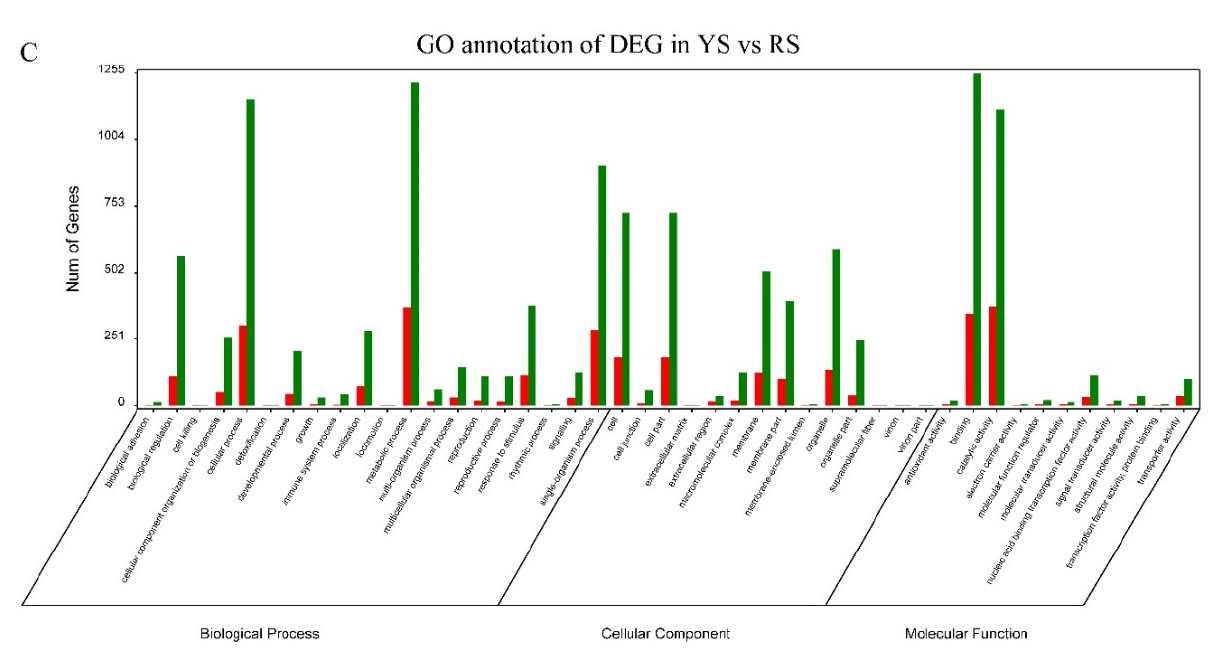
Figure 6. GO annotation of up- and downregulated expression genes of ‘Huaxiu’ plums ( P. salicina ) unigenes. ( A ): GO annotation in YS-vs.-OS; ( B ): GO annotation in OS-vs.-RS; ( C ): GO annotation in YS-vs.-RS.